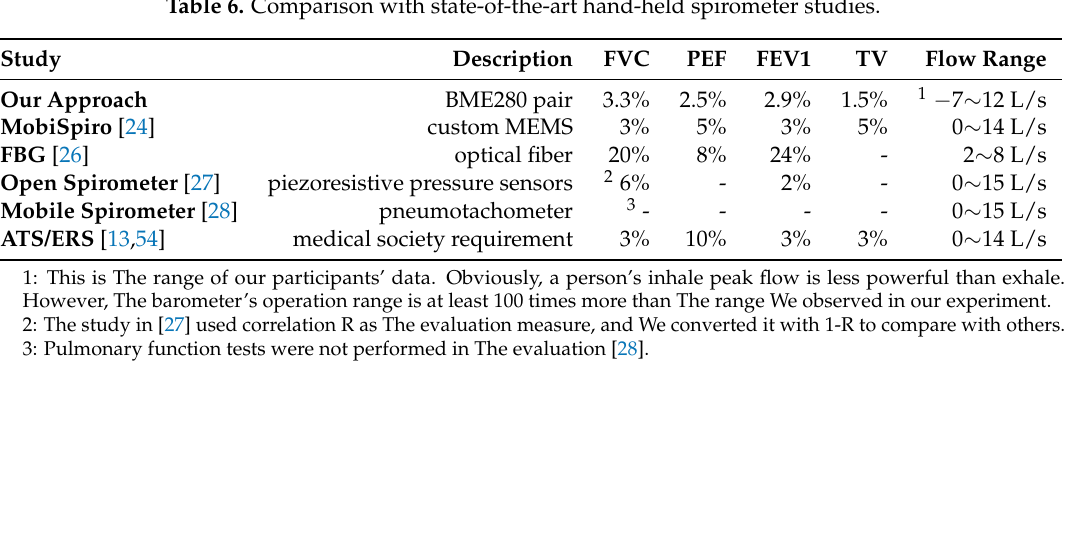
Table 6. Comparison with state-of-the-art hand-held spirometer